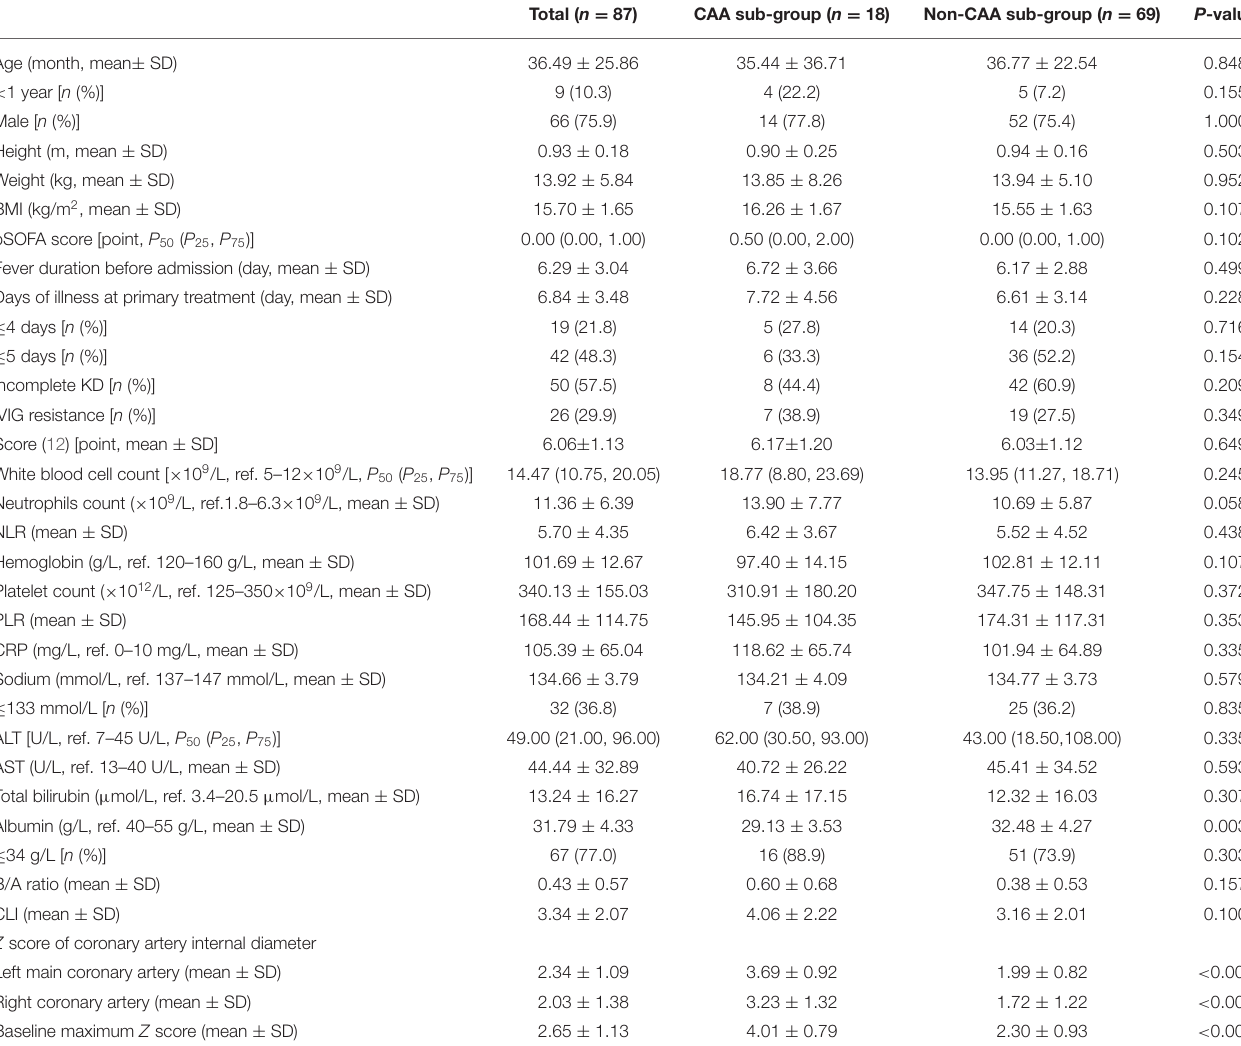
TABLE 4 | Comparisons of the baseline characteristics between the coronary artery aneurysm and non-coronary artery aneurysm